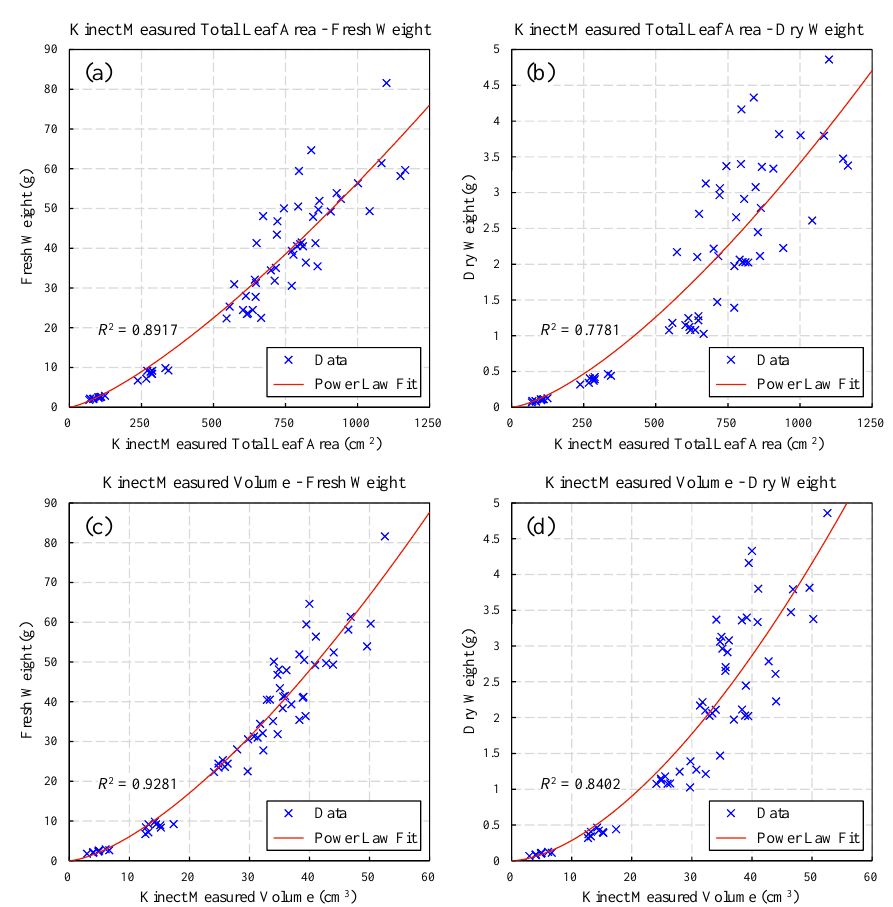
Figure 14. Correlations of Kinect measurements and biomass: Kinect measured total leaf area and fresh weight ( a ), Kinect measured total leaf area and dry weight ( b ), Kinect measured volume and fresh weight ( c ), and Kinect measured volume and dry weight ( d ). The original data for this figure can be found in Supplementary Material D.